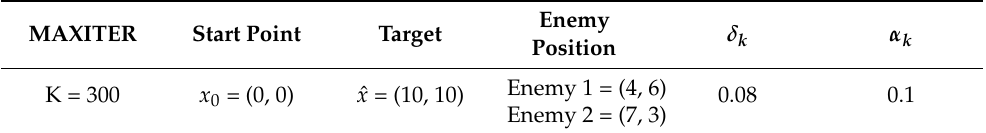
Table 1. Simple instance and parameters.